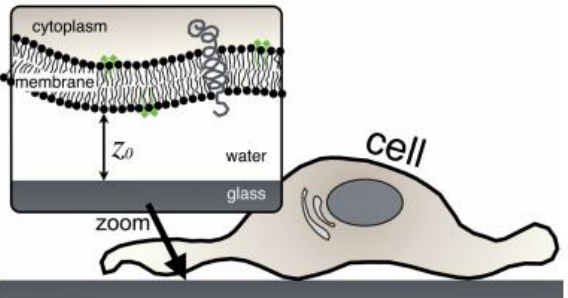
Figure 16. Schematic drawing of a cell spread on a glass substrate. Inset: the plasma membrane is labelled with DiO (green, fluorescent, lipophilic carbocyanine dye). z 0 is the distance from the substrate to the plasma membrane. (Reproduced with permission from [202] under Creative Commons Attribution 4.0 International License).